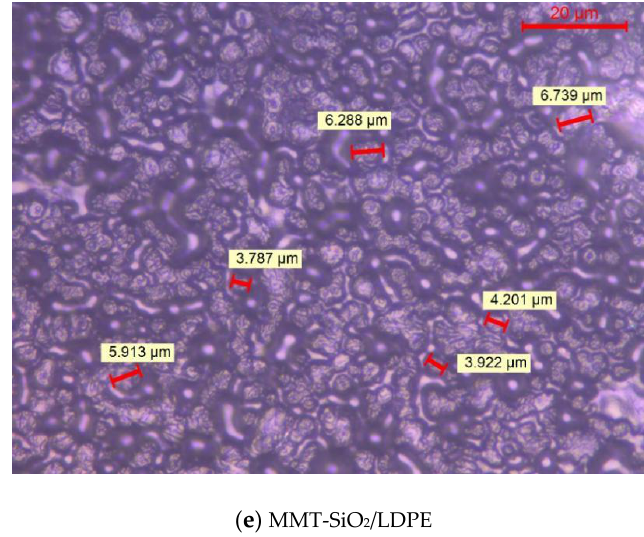
Figure 2. The crystalline morphology of various samples.